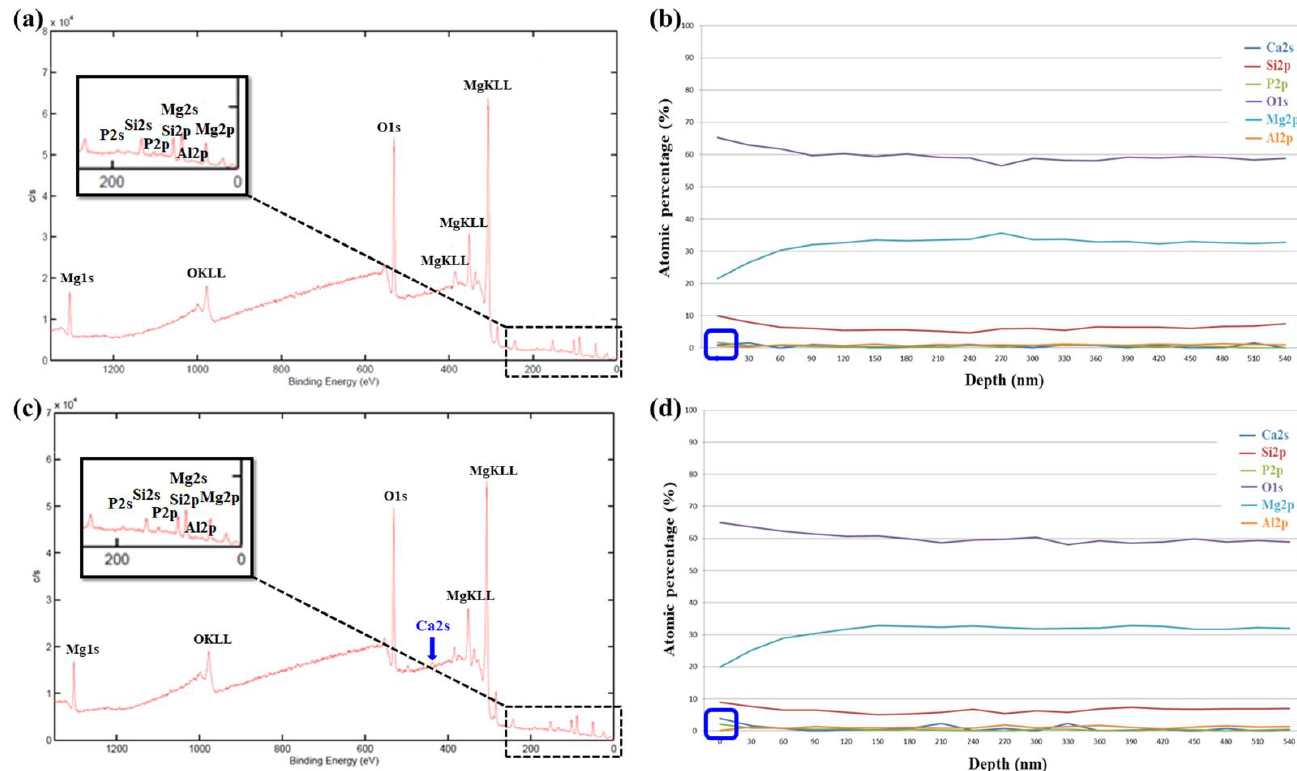
Figure 9. XPS surface full spectrum and depth profile of the AZ31 sample treated in the EDTA ( a , b ) 0 g and ( c , d ) 7.5 g bath. Table 6. Content of Ca and P elements of MAO coated sample. Non-Immersed in SBF After Immersed in SBF for 48 h EDTA 0 g Bath EDTA 7.5 g